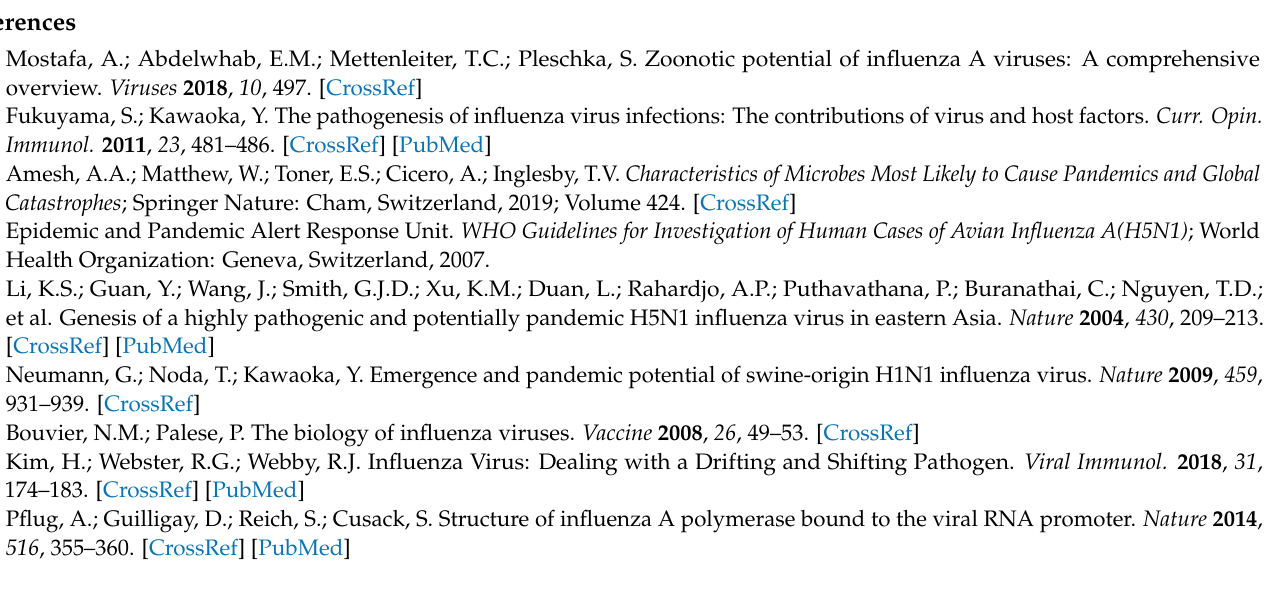
Table S2: DNA primers used for reverse transcription, Table S3: vRNA5 nucleotide reactivities, Table S4: Base pairs counts for secondary structure of